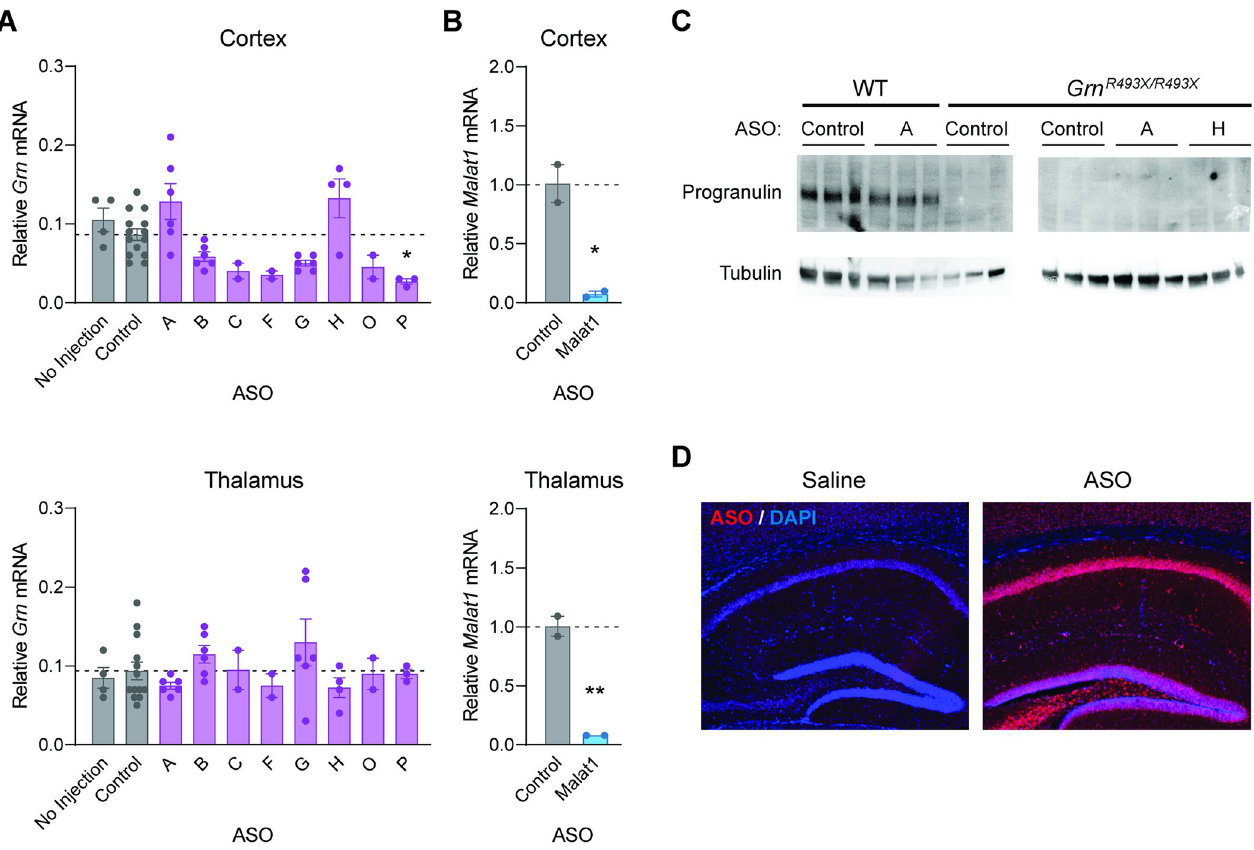
Fig 1. ICV administration of ASOs targeting NMD of the Grn R493X mRNA does not increase progranulin mRNA or protein levels in the brains of Grn R493X/R493X mice. qPCR results from brains of Grn R493X/R493X mice at 2–3 weeks after ICV administration of 200–500 μ g ASO. (A) Grn mRNA levels are presented relative to levels in tissues of wild-type mice that received control ASO. (B) Malat1 mRNA levels in wild-type mice. (C) Western blot of mouse progranulin levels in cortex of Grn R493X/R493X mice at 2 weeks after ICV administration of 500 μ g ASO. (D) At 3 weeks after ICV administration of saline or ASO B (200 μ g), brains were fixed and sections were stained with an ASO-antibody (red) and counterstained with nuclear stain DAPI (blue). Data are presented as means ± SEM; � indicates p < 0.05 and �� indicates p < 0.01, as determined by one-way ANOVA with Tukey post hoc test in (A) and by t-test in (B). WT, wild-type.